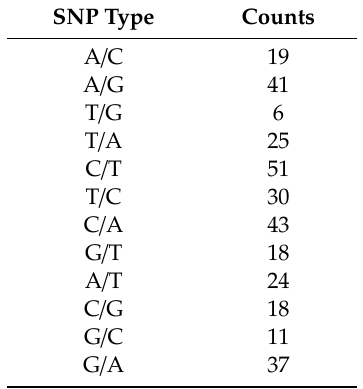
Table 4. Counts of di ff erent types of nucleotide transversions and transitions in heterozygous sites in the genome of B. naardenensis CBS